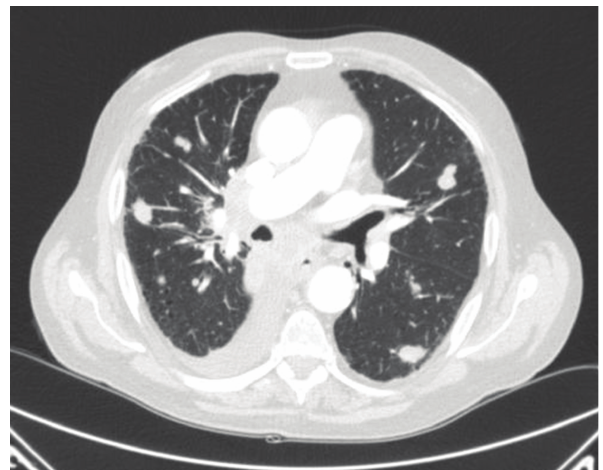
Figure 1: CT scans with multiple bilateral nodules and right pleural e ff usion.